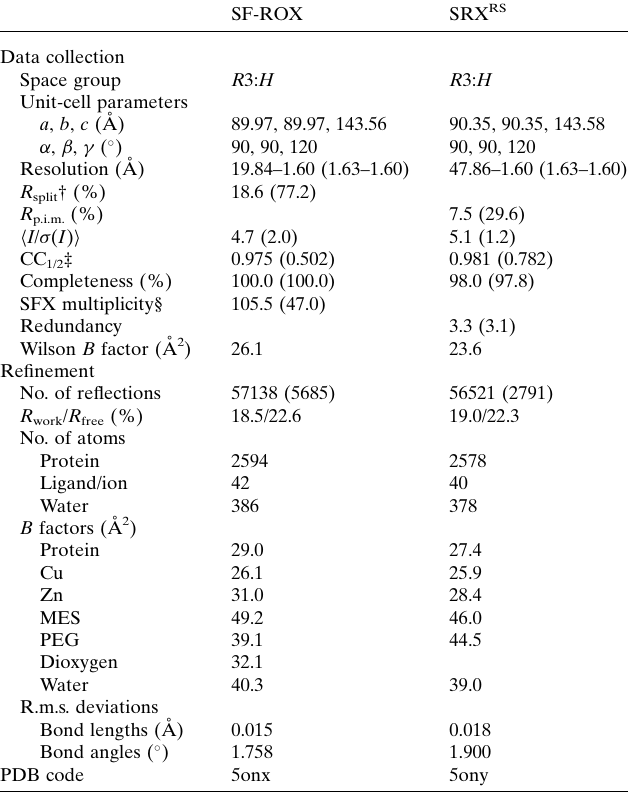
Table 1 Data-processing and refinement statistics. Values in parentheses are for the highest resolution